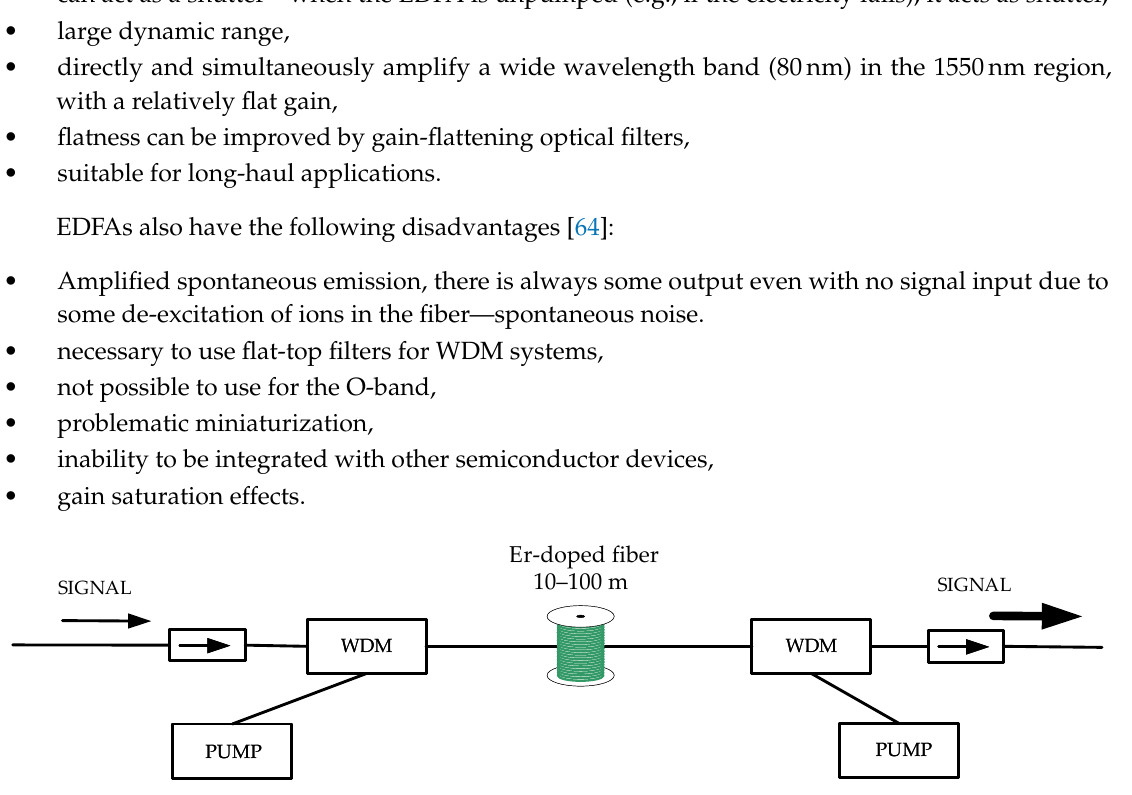
Figure 7. Schematic diagram of an erbium-doped fiber amplifier (EDFA) with backward and forward